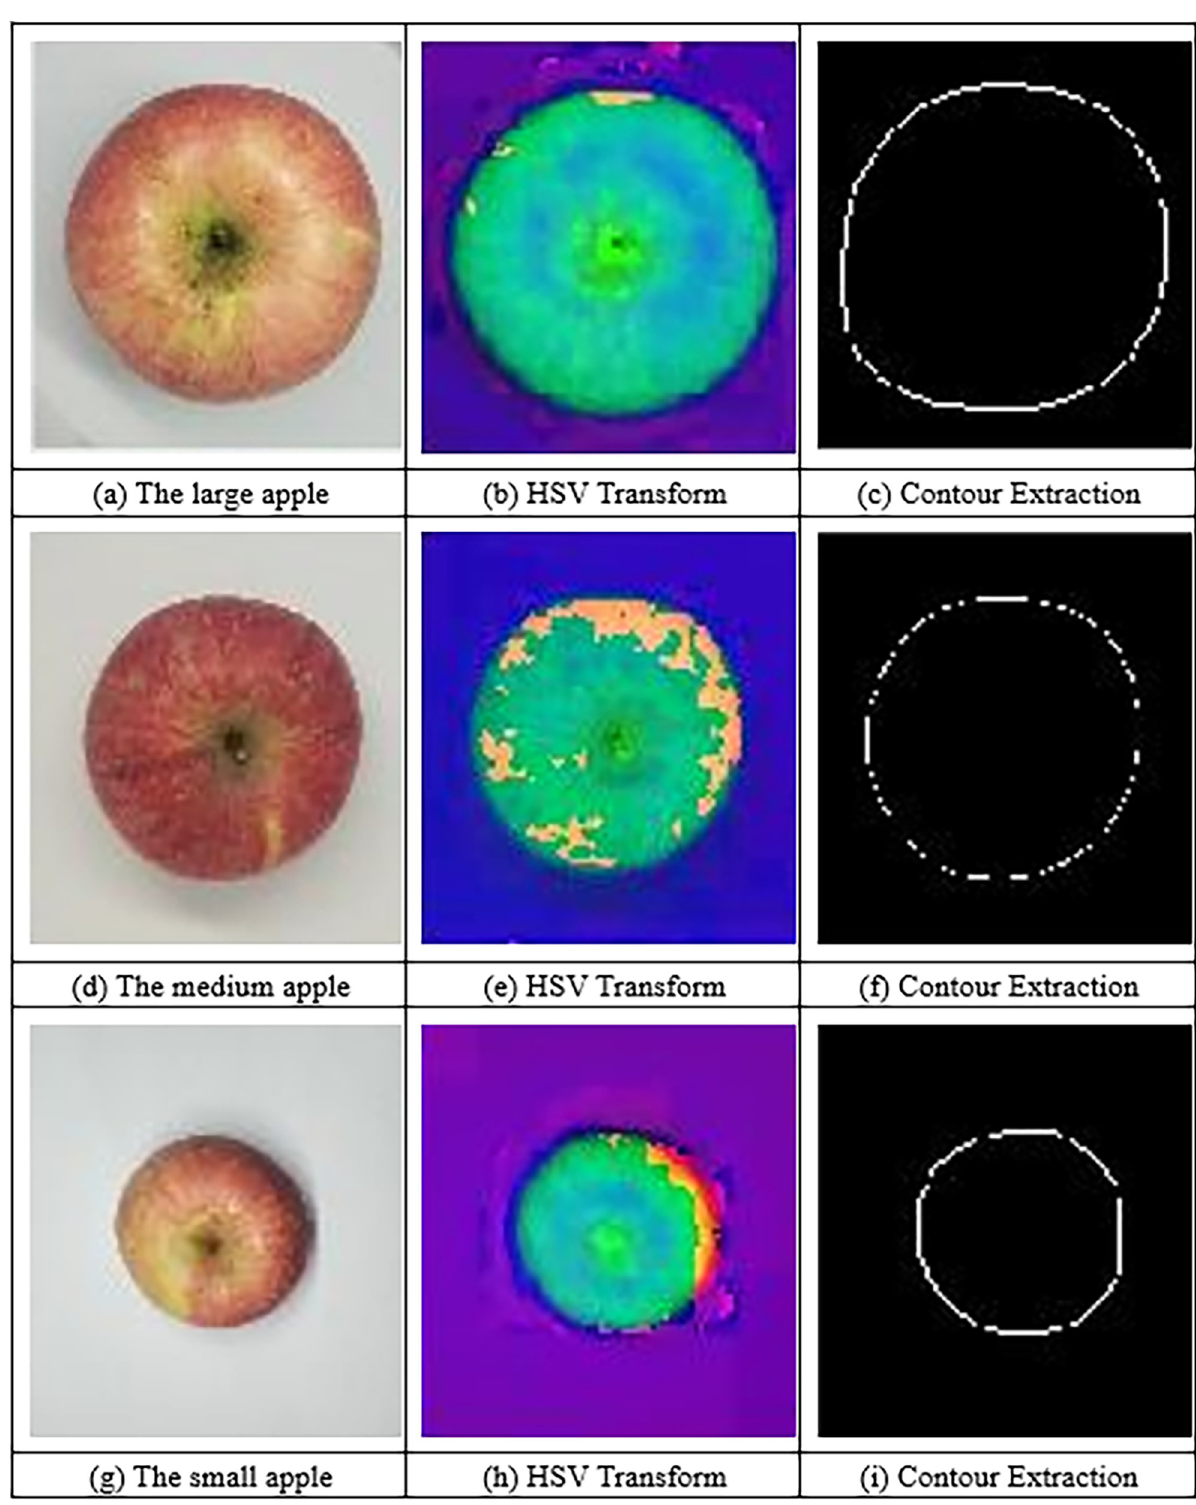
Fig 7. The extraction process of contours of apples with different sizes. (a) The large apple (b) HSV transform of the large apple (c) Contour extraction of the large apple (d) The medium apple (e) HSV transform of the medium apple (f) Contour extraction of the medium apple (g) The small apple (h) HSV transform of the small apple (i) Contour extraction of the small apple.